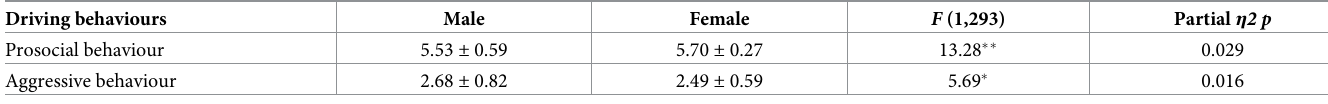
Table 2. Gender differences in prosocial and aggressive driving behaviours ( M±S D). Driving behaviours